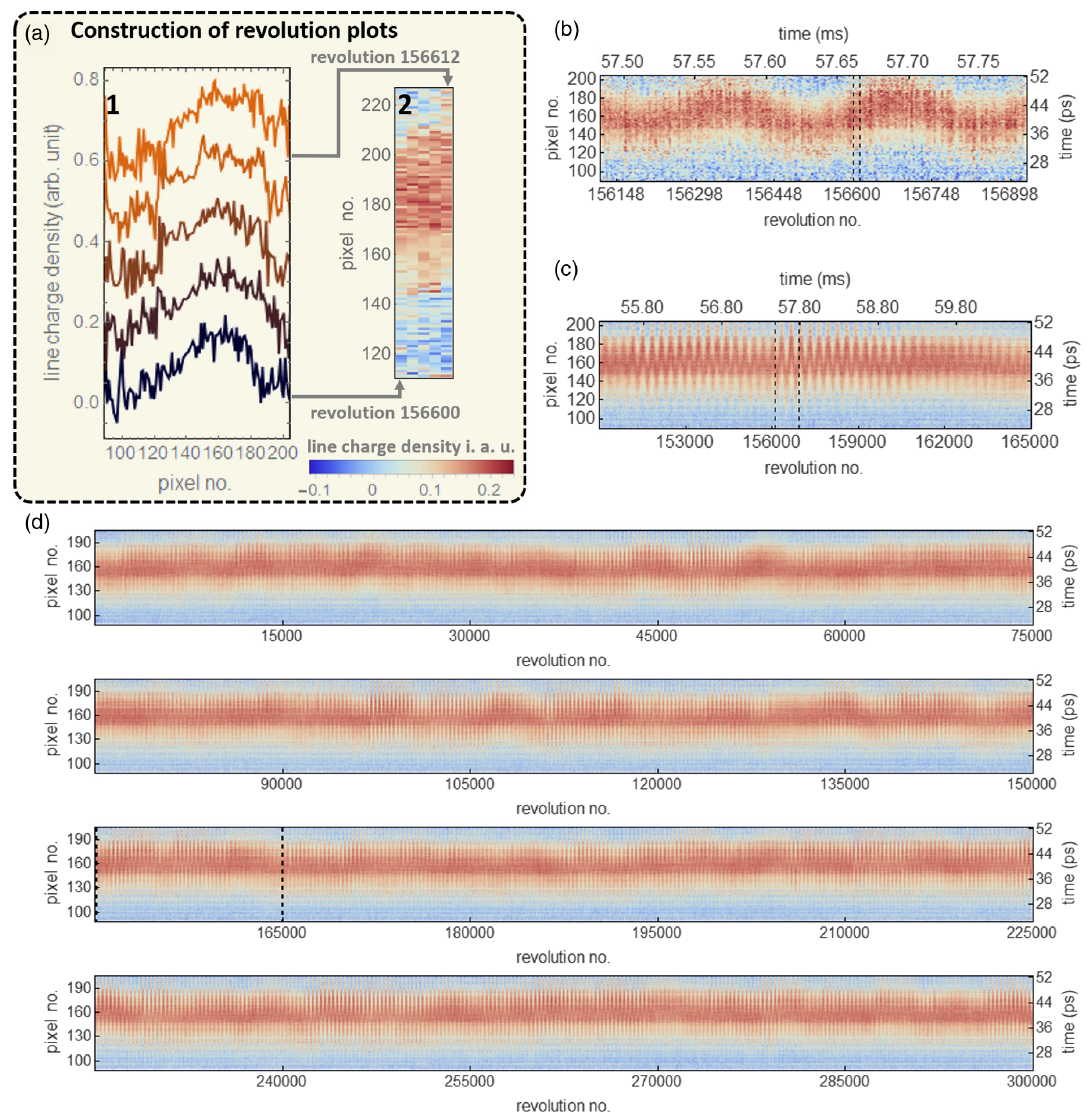
FIG. 4. Presented is the construction of revolution plots from single-shot measurements in (a) followed by (b) – (d) stepwise zoom outs with an increasing number of data points. (a) On the left side in part 1, 5 consecutive measurements are displayed via vertical stacking. On the left side in part 2, the corresponding revolution plot is shown. For the revolution plot, the measurements are stacked horizontally. Therefore, values of the line charged density are encoded by the color scheme shown at the bottom, for every pixel respectively. (b) displays a time interval of 0.3 ms, (c) a time interval of 5.55 ms, and (d) a time interval of 110.11 ms spanning the complete data stream of 100 000 measurements. The dashed lines refer to the time interval of the previous plot, respectively. The right time axis for each plot is obtained from previous calibration measurements by using the laser synchronization system. We estimate the conversion factor to be ð 0 . 256 (cid:3) 0 . 016 Þ ps =